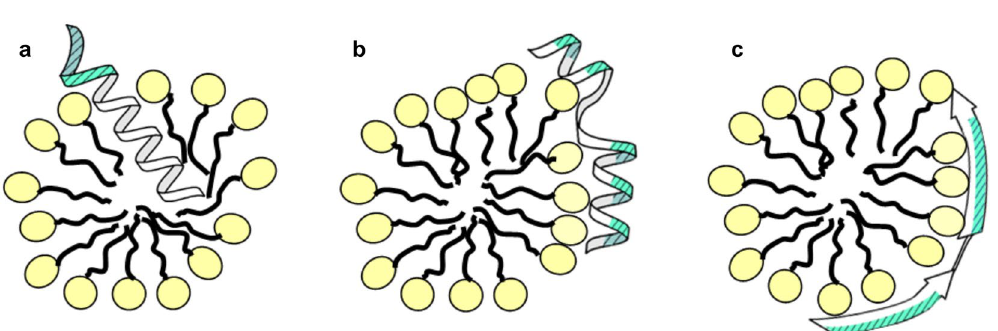
Figure 8. The effect of LPA on the peptide structure studied with ATR-FTIR. Complex formation was initiated by mixing the components with a peptide-to-lipid ratio of ~1:5 using concentrations of 200 μ M and 1 mM for the peptide and the lipid, respectively. Spectra were collected for the mixture immediately after mounted (solution, a ) as well as for the surface-dried sample ( b ), respectively.